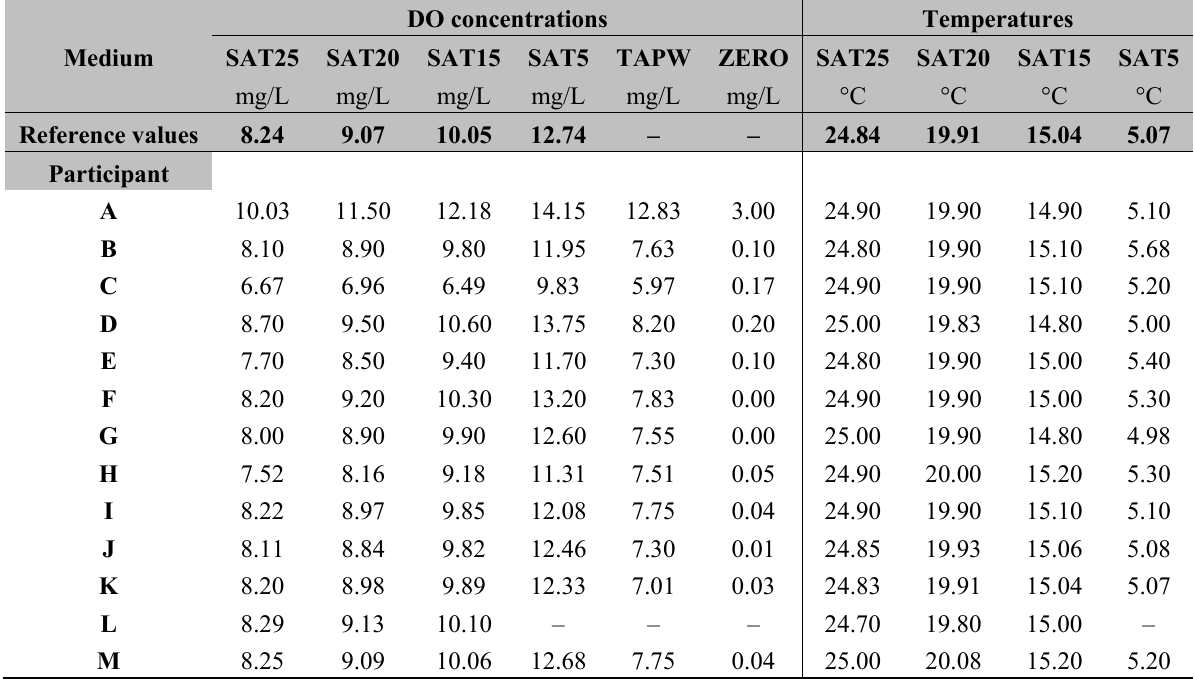
Table 3. DO Readings of the Participant Instruments.